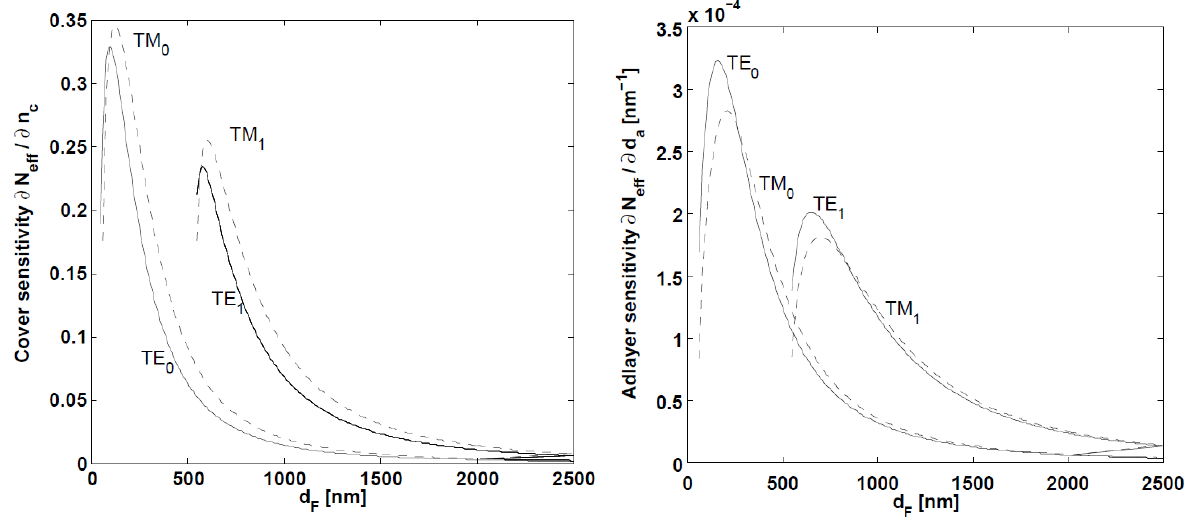
Figure 2. Calculated sensitivities for a refractive index sensor based on the PMMA- CYTOP slab waveguide platform (633 nm operating wavelength). Sensitivity of the guided mode index to the refractive index of the cover layer ( left ) and the thickness of an adsorbed layer with an index of n = 1.5 ( right ), plotted for different thickness of the waveguide core layer, d F